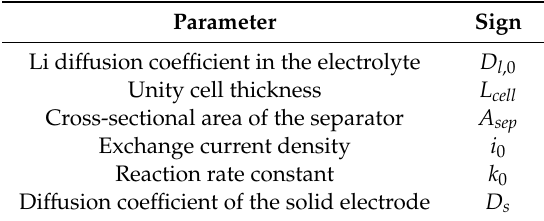
Table 1. List of core electrochemical parameters to be